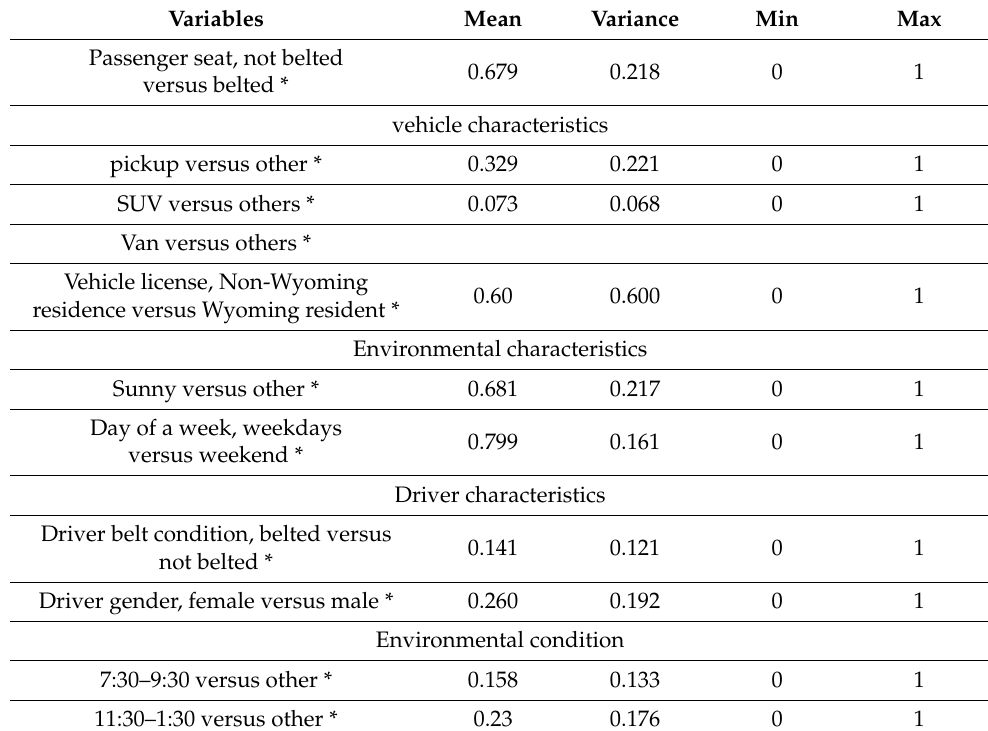
Table 1. Descriptive summary of important